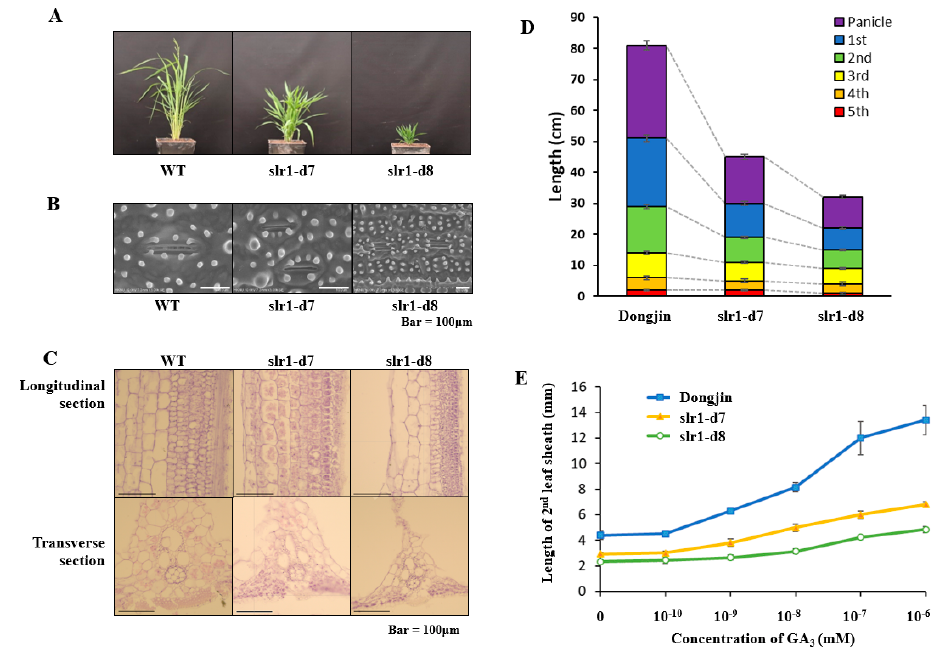
Figure 2. Phenotypic analysis of wild-type (WT) and slr1 mutant plants. ( A ) Phenotype of mature WT and mutant plant lines. ( B ) SEM (scanning electron microscopy) images of rice stomata in slr1-d7, slr1-d8 and WT. ( C ) Longitudinal tissue sections of the main stem at the mature stage in WT and slr1 mutant using paraffin section. Bar: 100 μ m. ( D ) Length of internodes in slr1-d7, slr1-d8 and WT. ( E ) Elongation of the second leaf sheath of slr1-d7 and slr1-d8 in response to exogenous treatment with di ff erent concentrations of GA 3 . Error bars are SD from the mean ( n = 3).